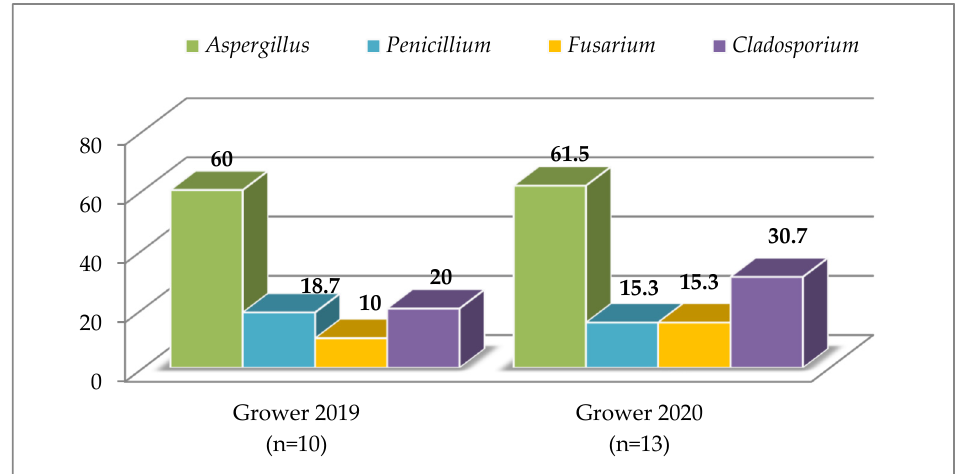
Figure 4. Proportion (%) of potentially toxigenic fungal genera in positive grower compound feed samples (n—number of positive samples).